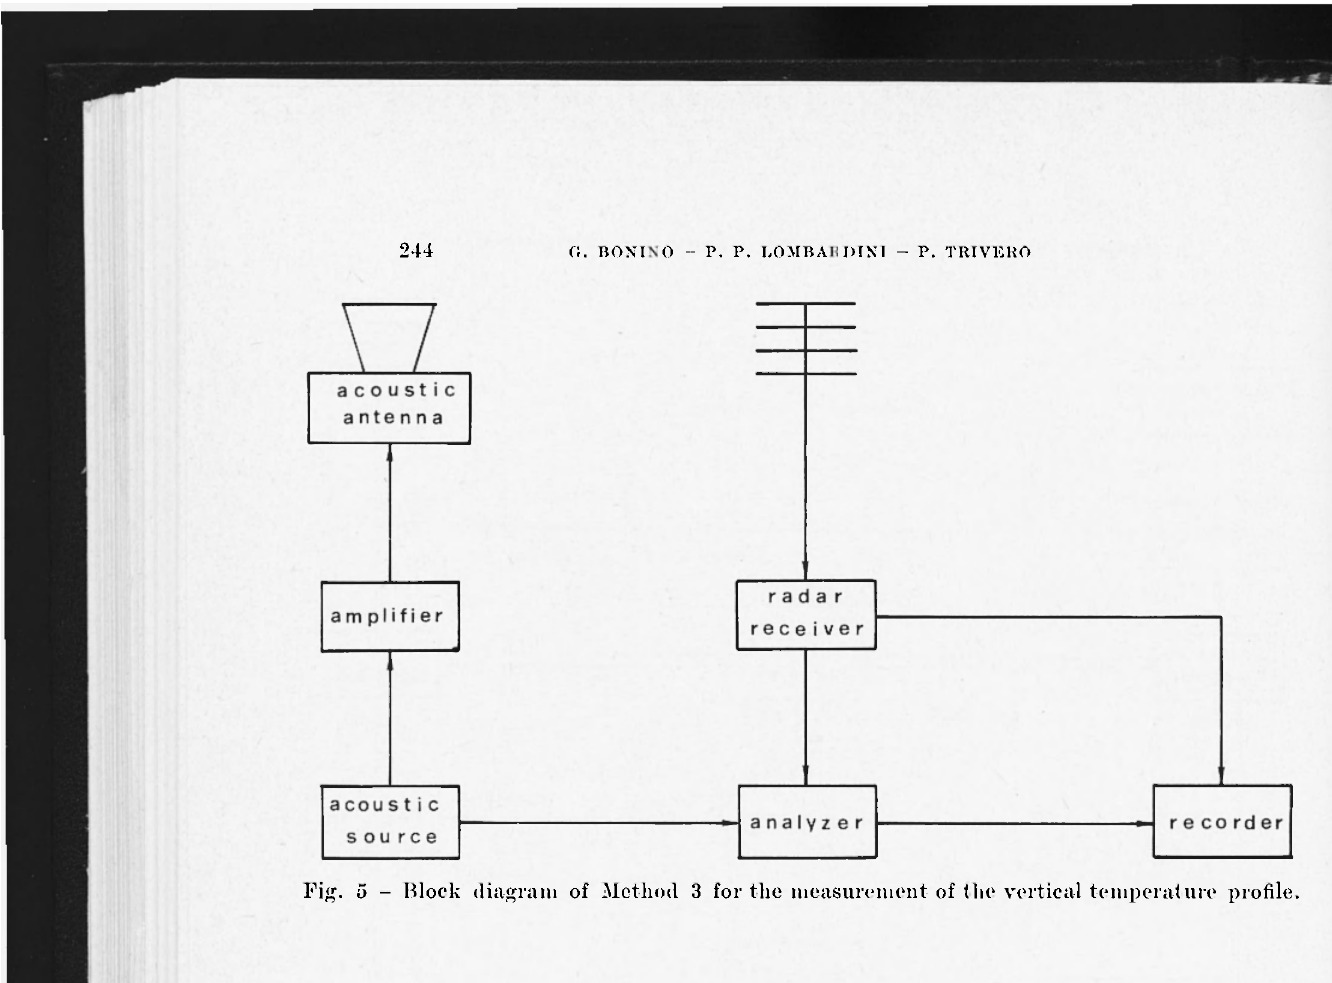
Fig. 5 - Block diagram of Method 3 for the measurement of the vertical temperature